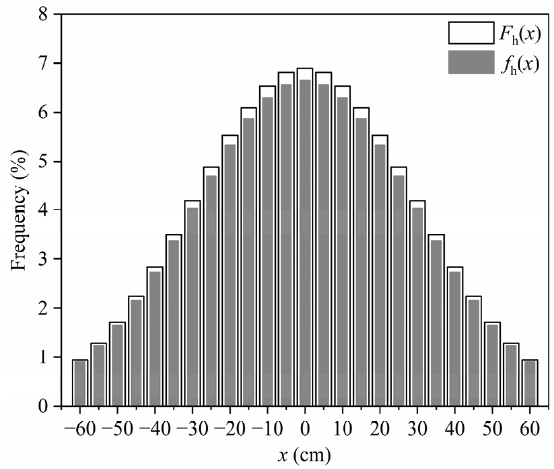
Figure 6. Transverse distribution frequency of human ‐ driven vehicles.